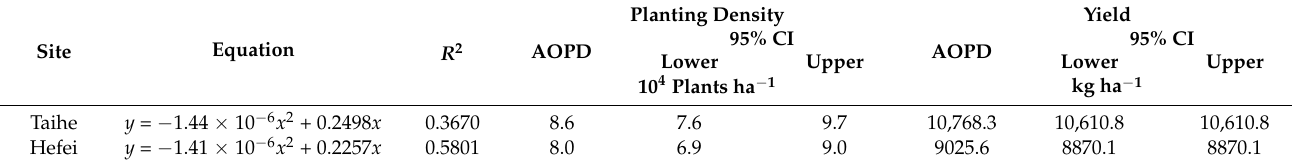
Correspondingly, these results suggested that the simulated grain yield in Taihe was 19.3% higher than in Hefei. Table 5. Quadratic equations that best fit the yield–density relations, agronomic optimal planting density (AOPD), 95% confidence interval (CI) of the AOPD, yield at the AOPD, and at the upper and Table 5. Quadratic equations that best ft the yield-density relations, agronomic optimal planting density 266 lower limits of (AOPD), 95% confidence interval (CI) of the AOPD, yield at the AOPD and at the upper and lower limits 267 of AOPD.